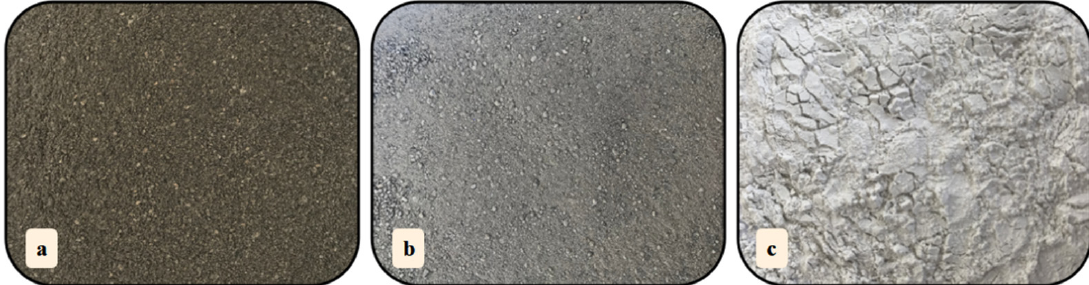
Figure 1. Photos before consolidation: ( a ) OSR, ( b ) SS and ( c ) GGBS.